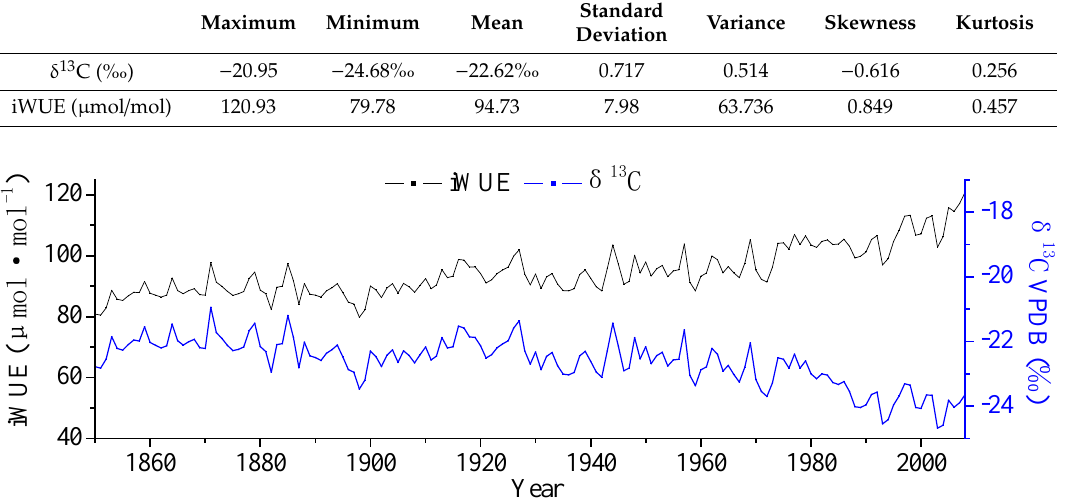
Table 1. The statistical characteristics of tree-ring δ 13 C and iWUE (1850–2008).